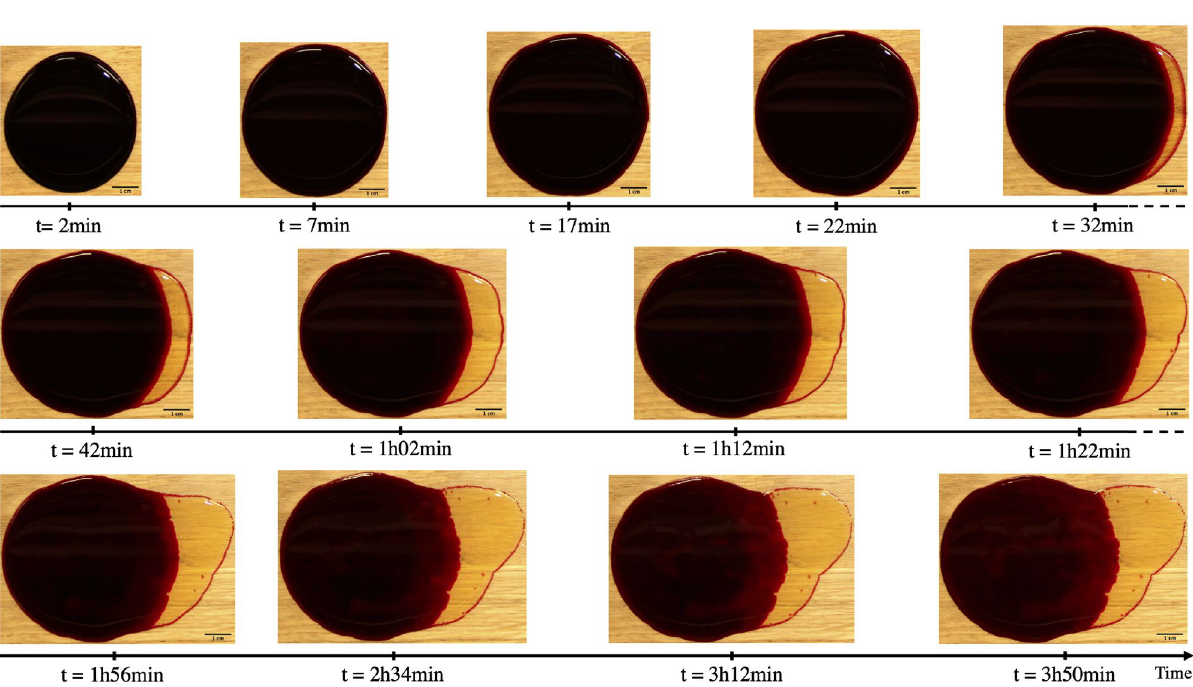
Figure 3. Time lapse of a drying pool of blood ( m i = 4.83 g , hct = 41.5% ) on varnished wooden floors at 21 ◦ C with a relative humidity of 60% , showing spreading and serum separation. For a movie of the drying blood pool, see the Supplementary